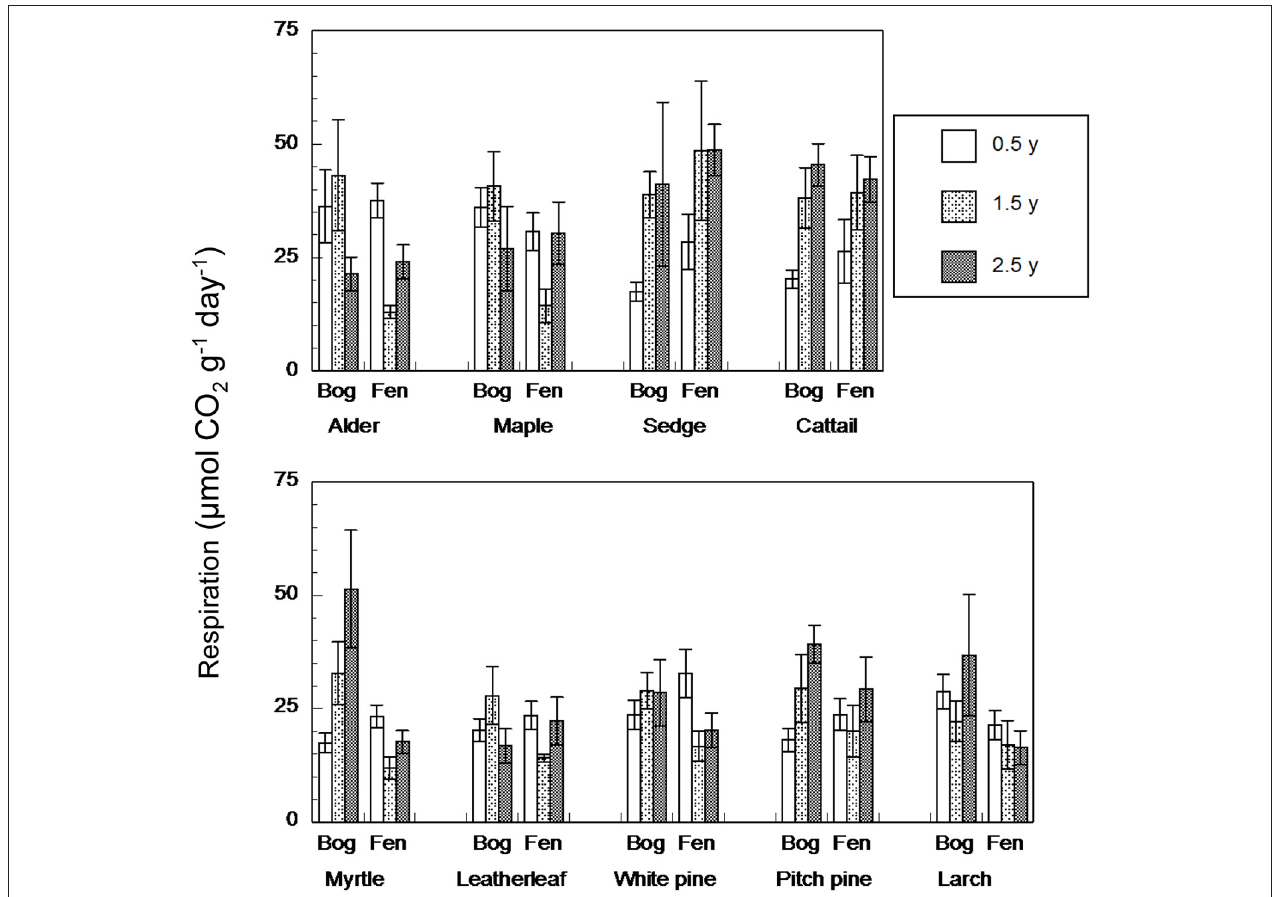
FIGURE 3 | Rates of anaerobic respiration ( µ mol CO 2 g − 1 dry residue d − 1 ) by leaf litter residue from nine species having decayed in bogs or in rich fens for three amounts of time. Values are mean + standard error; n = 10 for 0.5 year, n = 4 for 1.5 years, n = 5 for 2.5